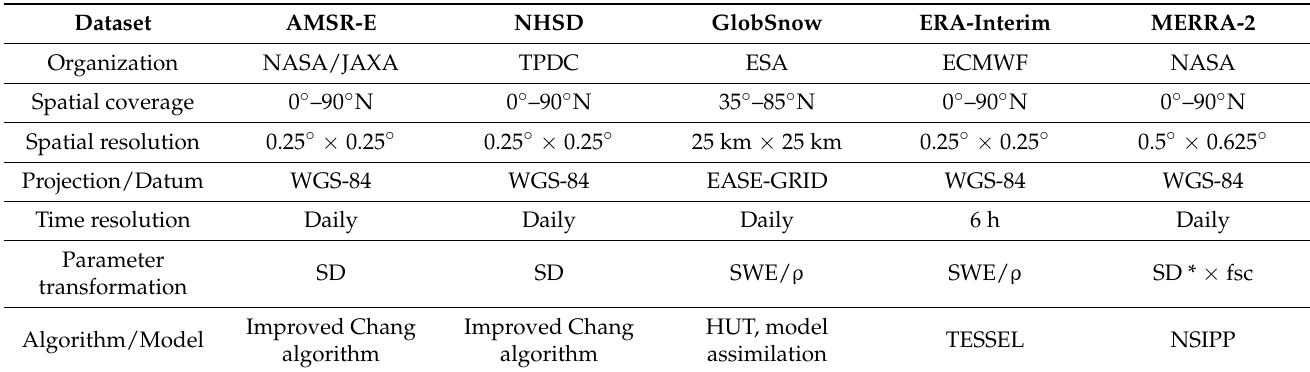
Table 1. Summary of the main snow depth datasets used in this